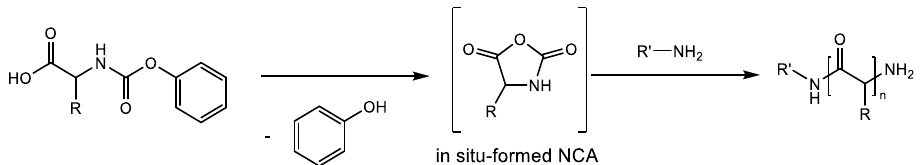
Figure 7. Synthesis of polypeptides via polymerization of NPCs.